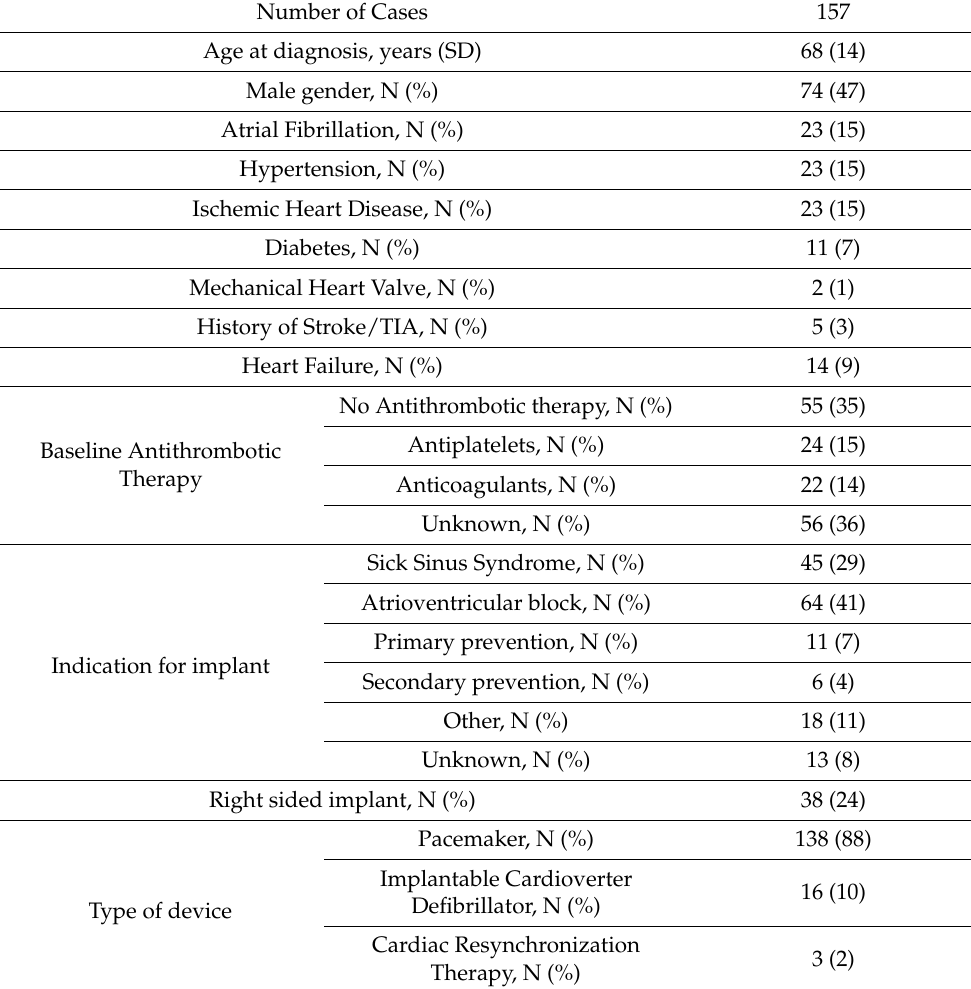
Table 1. Baseline characteristics of patients with Inadvertent lead malposition in the left heart chambers.